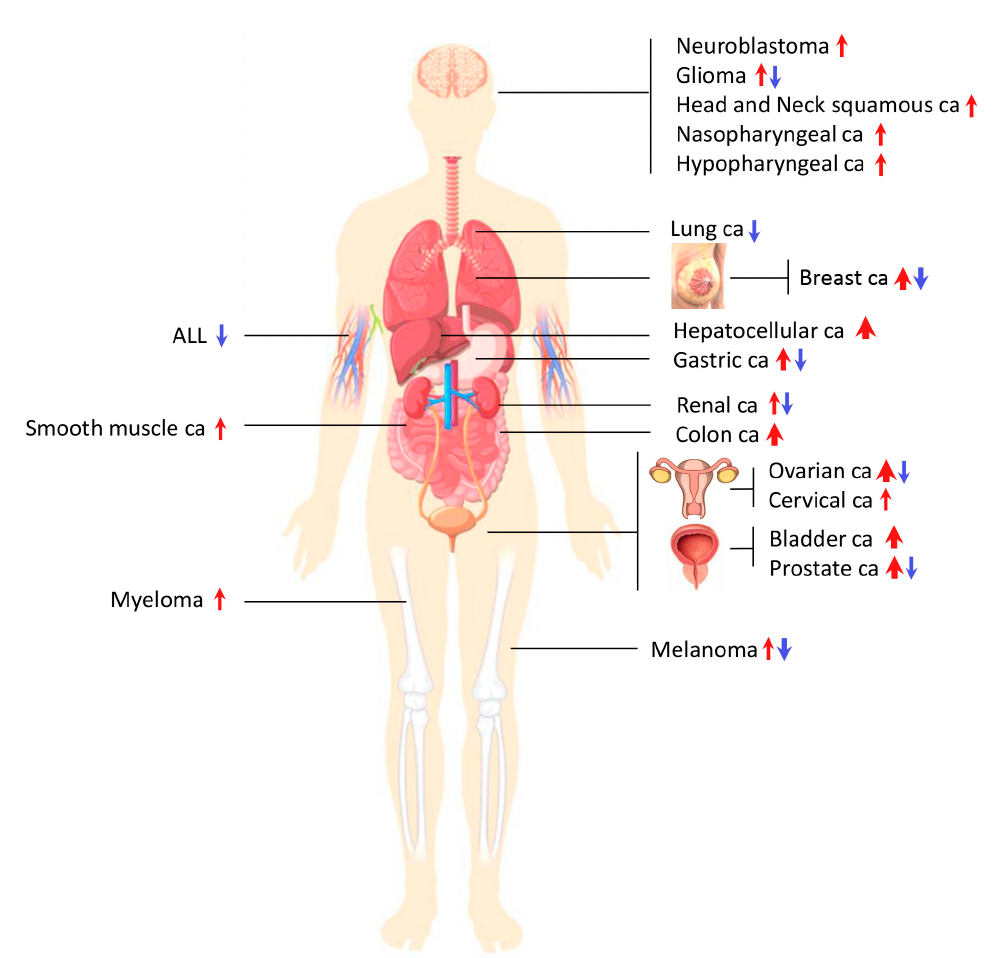
Figure 3. Deregulation of AGO-expression patterns in human cancer. The red and blue arrows indicate the increase and decrease of AGO-expression levels, respectively. The width of each arrow denotes the number of studies in which deregulated AGO contents were identified. Elevated AGO levels were reported in neuroblastoma, head and neck squamous, nasopharyngeal, hypopharyngeal, hepatocellular, colon, cervical, bladder, smooth muscle carcinomas, and myeloma. Reduced AGO levels were detected in lung adenocarcinoma and in acute lymphoblastic leukemia. Conflicting results, demonstrating both upregulation and downregulation of AGO expression, were described in breast, prostate, ovarian, gastric, and renal carcinomas as well as in glioma and